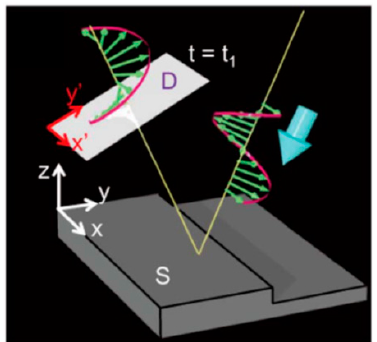
Figure 1. Schematic of the T-ray topography which utilizes the polarization information of the terahertz waves. “S” represents the sample and “D” represents the spinning EO sensor to detect the magnitude and direction of the terahertz E-field. (Reprinted with permission from reference [66], Optical Society of America.)